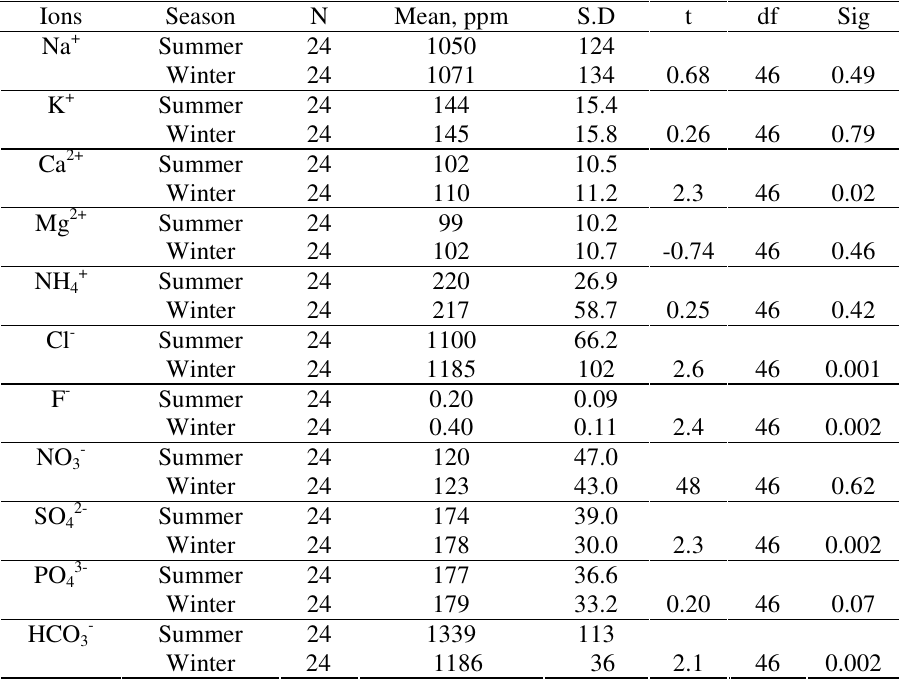
N: number of samples Table 3. Statistical difference between the average concentration of the major cations and anions in wastewater effluent for both